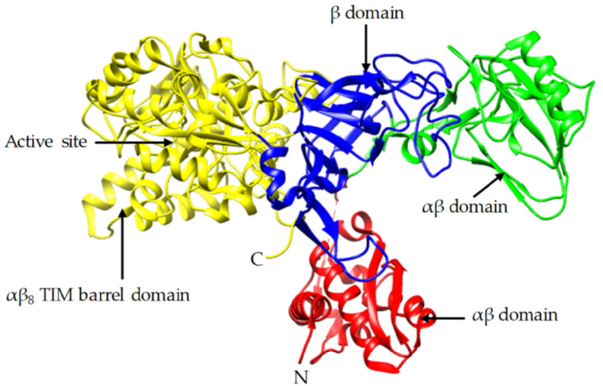
Figure 4. Crystal structure of jack bean